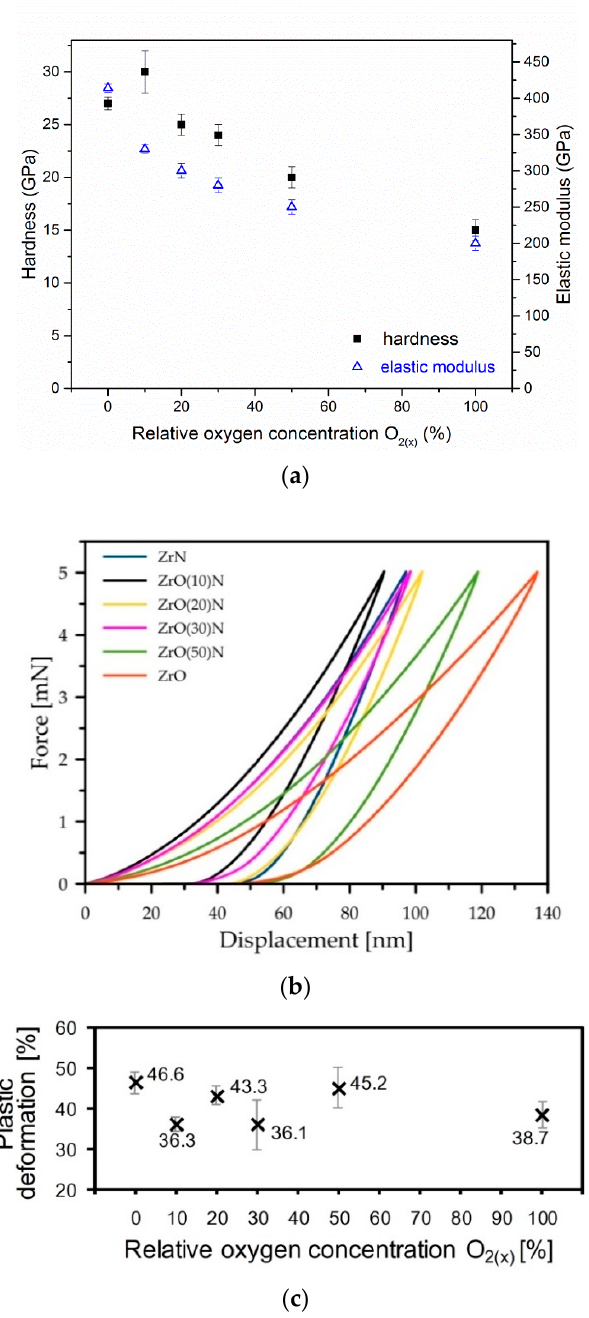
Figure 9. The dependences of hardness and Young modulus ( a ), indentation curves shape ( b ) and plastic deformation ( c ) of ZrON coatings with different O 2(x) . According to the shape of the nanoindentation curves, the plastic deformation of the Zr-O-N coatings does not depend on the oxygen content (Figure 9b,c). The “high” values (43.3–46.6%) were determined for ZrN, ZrO(20)N and ZrO(50)N. The “low” values (36.1–38.7%) were measured for ZrO 2 , ZrO(10)N and